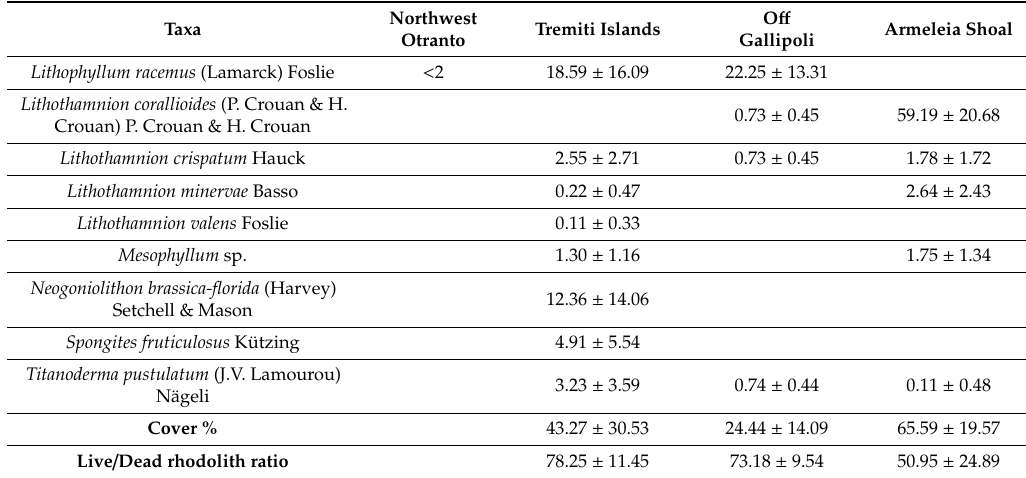
Table 2. Results of PERMANOVAs testing for spatial differences in the proportion of living thalli and the rhodolith cover percentage at scales of area, site and transect. Estimates of multivariate variation are given for each spatial scale. df = degrees of freedom; MS = mean sum of squares; Pseudo-F = F value by permutation; p (perm) = p -values based on 9999 random permutations of appropriate units.